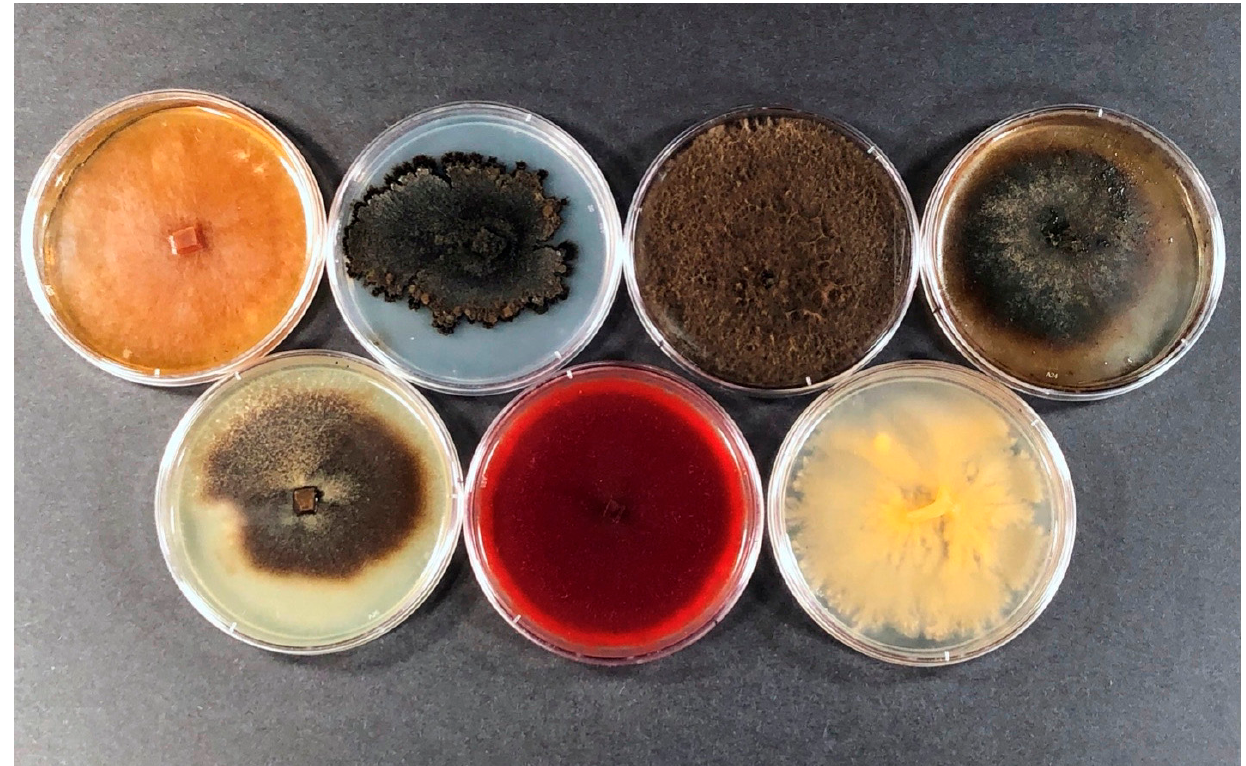
Figure 1. Pure cultures of fungi isolated from EAB galleries used for the study, top row form left to right: Cytospora pruinosa (EAB 67-4), Diplodia mutila (EAB 42-6), Diplodia seriata (EAB 64-12), and Paraconiothyrium brasiliense (EAB 58-13). Bottom row from left to right: Phaeoacremonium minimum (EAB 66-10), Phaeoacremonium scolyti (EAB 64-22), and Thyronectria aurigera (EAB 45-20).